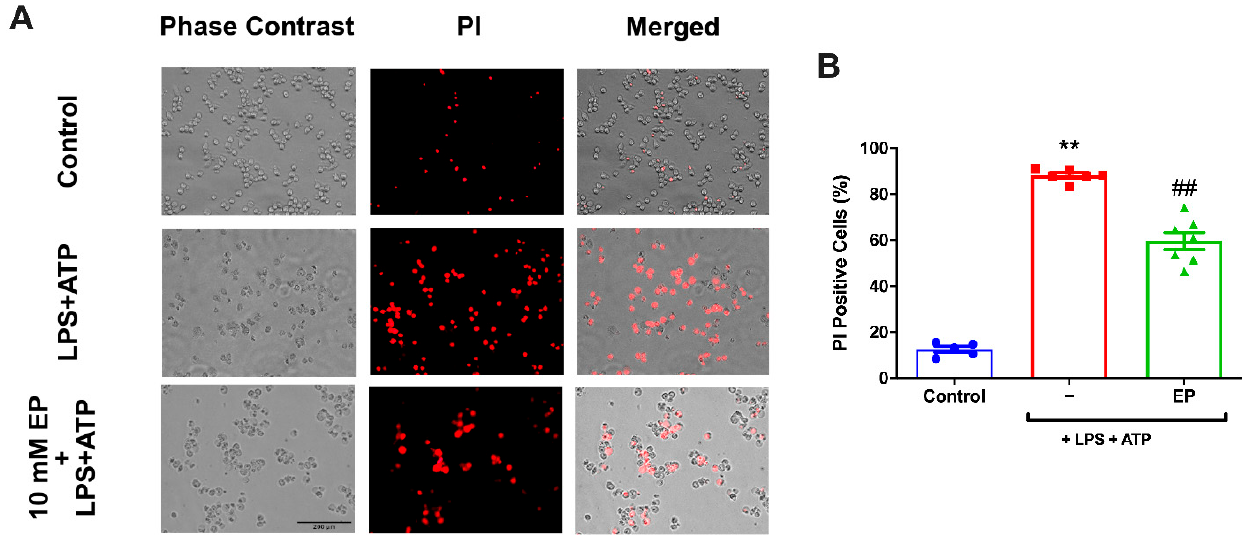
Figure 3. EP reduced pyroptotic cell death. N9 microglial cells were pretreated with EP (10 mM) for one hour, then treated with LPS (1 µ g/mL) for four hours, and ATP (5 mM) for 1 h. ( A , B ) EP reduced pyroptotic cell death and decreased PI-positive cells. All the data are presented as mean ± S.E.M, n = 5. ** p < 0.01 compared to control and ## p < 0.01 compared to LPS- and ATP-induced